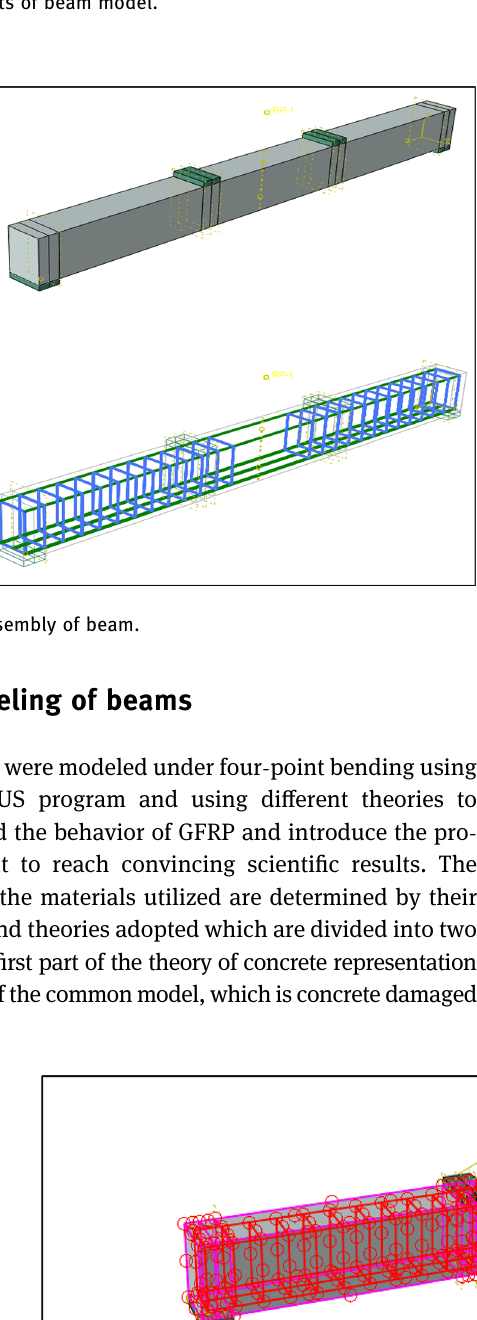
Figure 1: Parts of beam model.